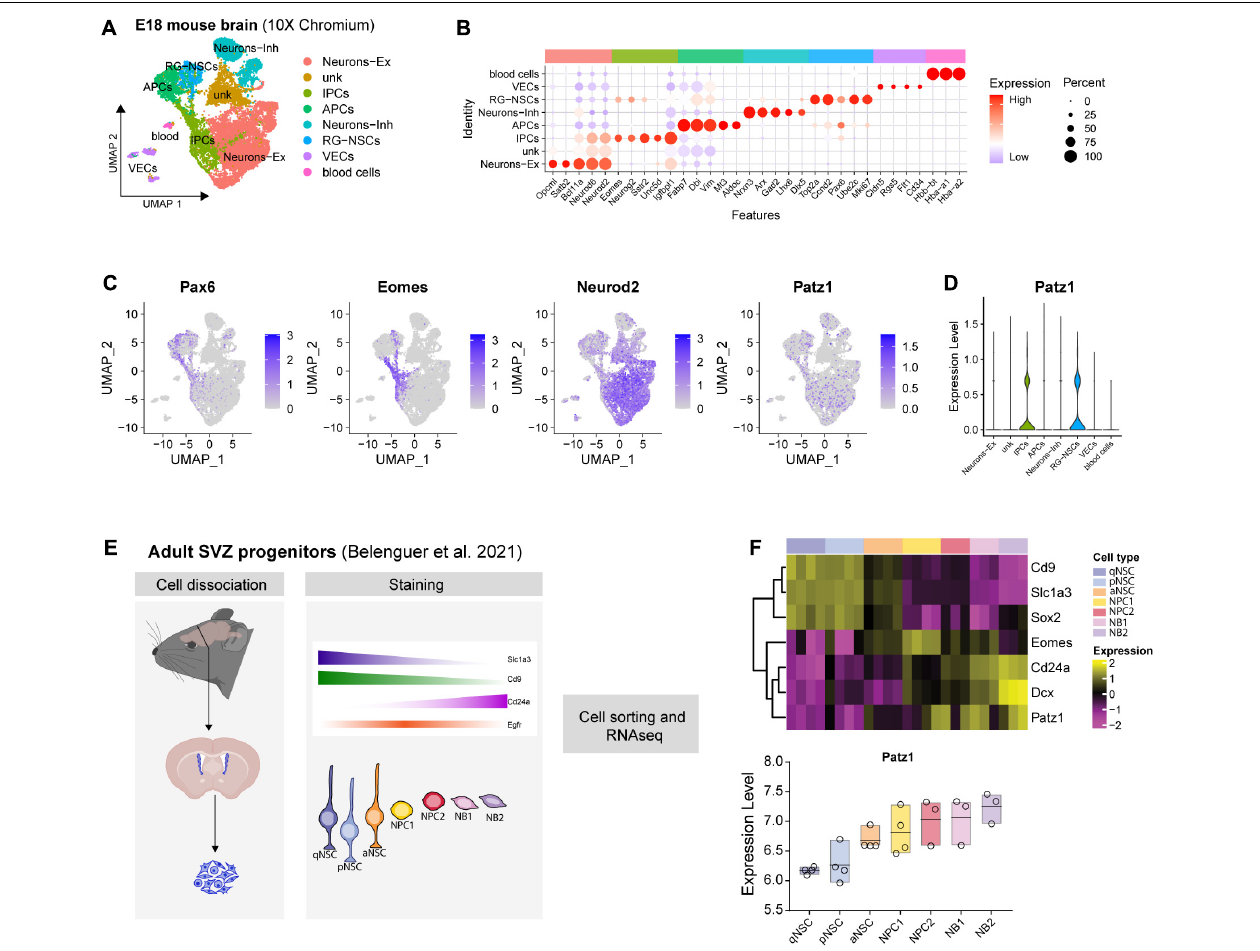
FIGURE 2 | Patz1 expression in embryonic and adult neural stem/progenitor cells. (A) UMAP plot showing the cell type composition of E18 mouse brain and (B) relative diagnostic cell marker enrichment in term of expression and percent of positive cells. (C) Feature plot of selected genes: Pax6 , Eomes (Tbr2) , Neurod2 , Patz1. (D) Violin plot showing Patz1 enrichment in Radial Glia and Intermediate Progenitor cell types. (E) Experimental scheme used by Belenguer et al. (2021) to isolate different neural stem/progenitor cells from adult murine SVZ. (F) Heatmap and box plot showing the expression of Patz1 and selected NS/PCs markers in adult murine SVZ. RG, Radial Glia; NSC, Neural Stem Cells; IPC, Intermediate Progenitor Cells; APC, Apical Progenitor Cell; VEC, vascular endothelial cell; Ex, Excitatory; Inh, Inhibitory; qNSC, quiescent Neural Stem Cell; pNSC, primed Neural Stem Cells; aNSC, activated Neural Stem Cells; NPC, Neural Progenitor Cell; NB, Neuroblast; SVZ, Subventricular